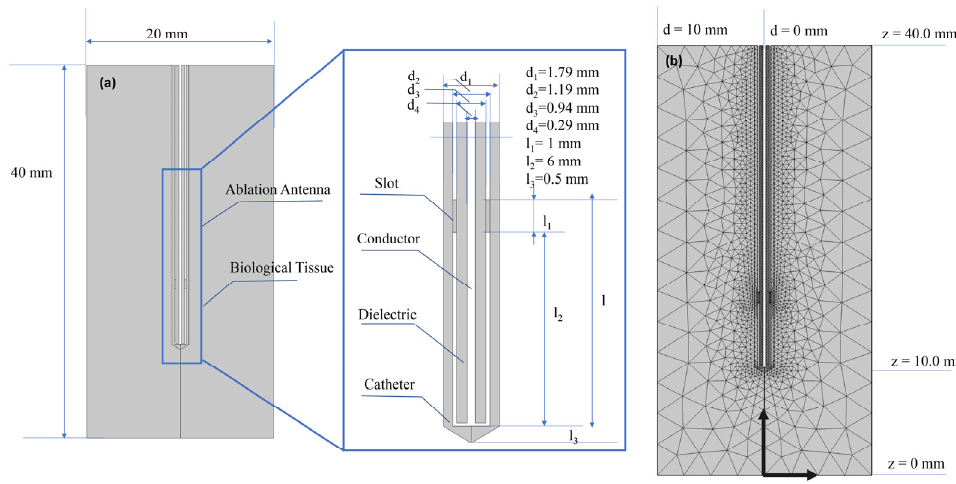
Figure 1. Schematic diagram of biological tissue model. ( a ) Geometric structure and parameters of biological tissue model. ( b ) A free triangular grid in biological tissue model. Its cylindrical coordinate mainly analyzes d and z directions.